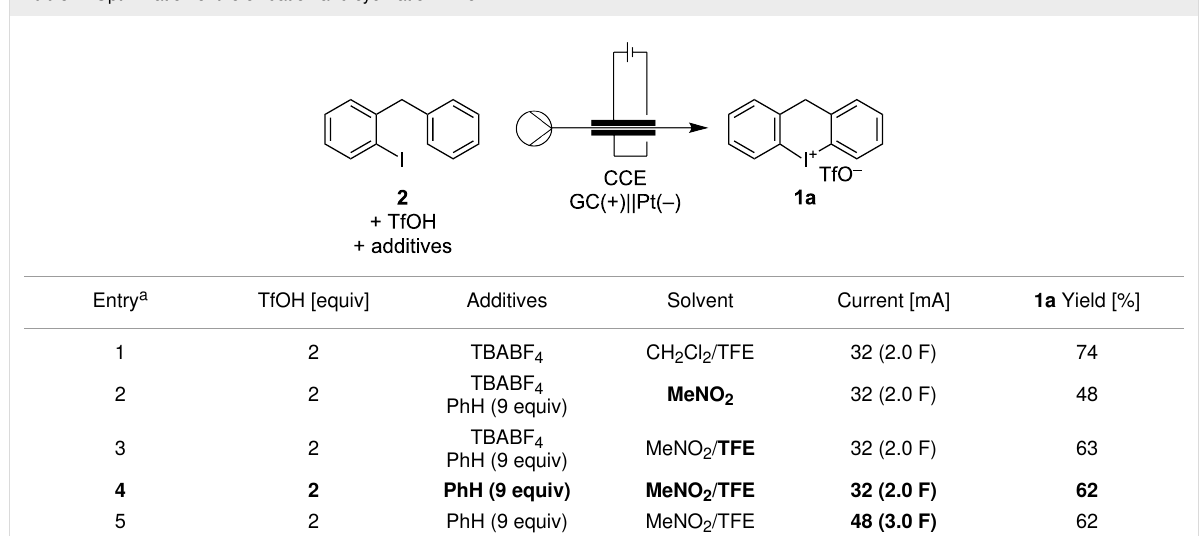
Table 2: Optimization of the oxidation and cyclization in